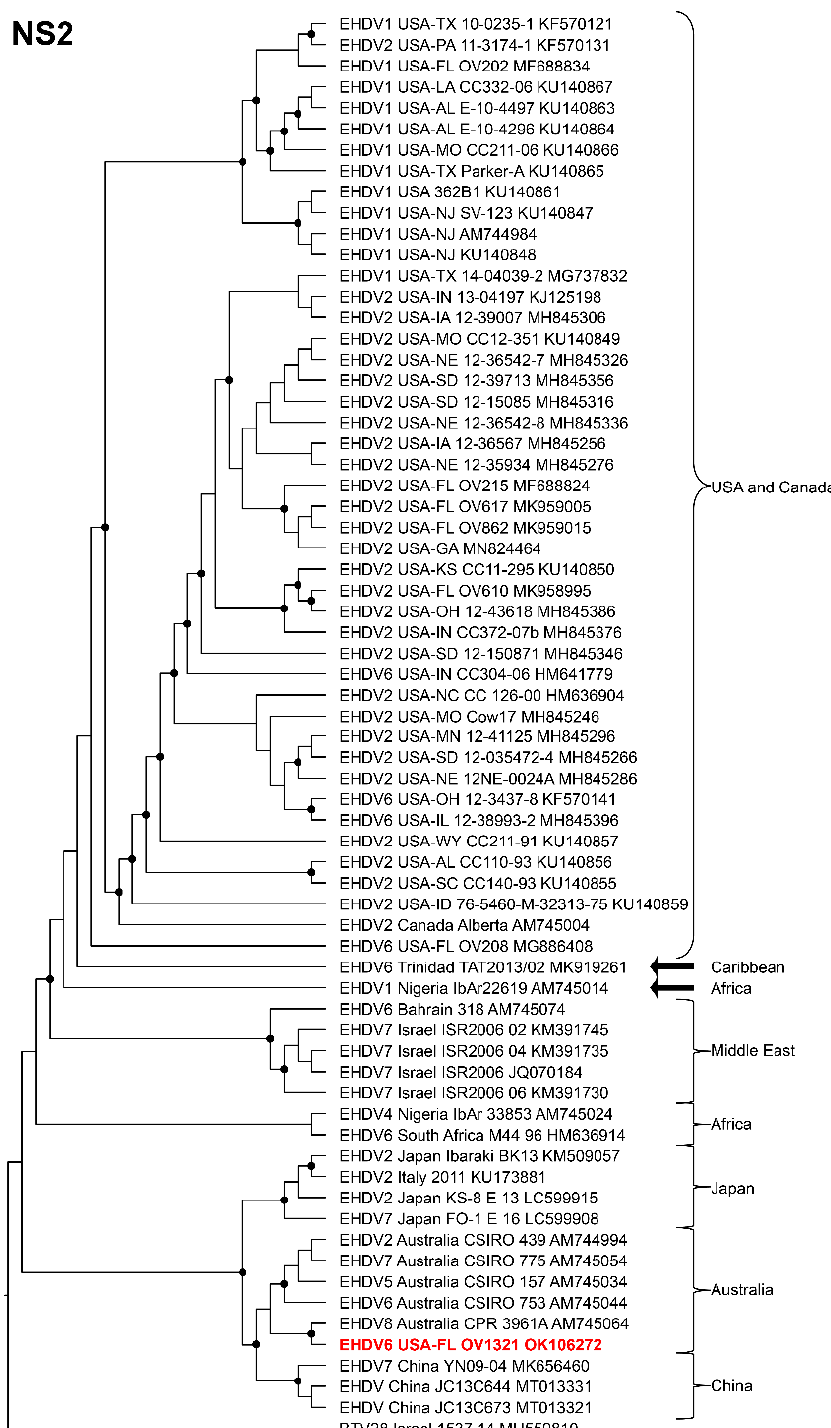
Figure 6. Maximum Likelihood cladogram depicting the relationships of the U.S. novel reassortant EHDV-6 strain isolated from a white-tailed deer (OV1321) to 67 other EHDV strains. The tree was generated from the nucleotide sequence alignment of the NS2 gene. The included EHDV and BTV strains are indicated by serotype, country, state (for U.S. strains), strain or isolate name, and GenBank accession no. Nodes with black circles are supported by bootstrap values ≥ 80%. The tree was rooted with the BTV-28 strain. Additional metadata for each virus in the tree are provided in Supplemental Table S1.